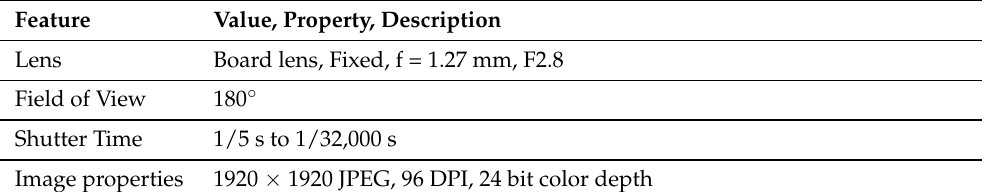
Table 1. Key features of the Vivotek FE8171V fish-eye camera [41], the main component of our optical package,